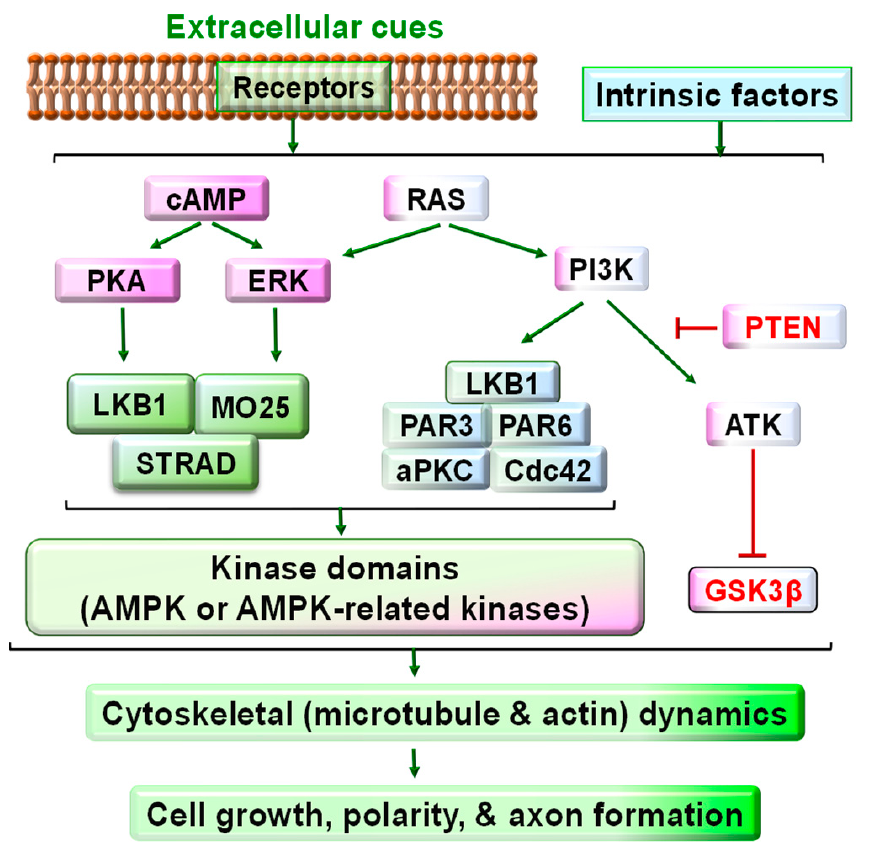
Figure 2. Schematic of the signaling pathways upstream and downstream of LKB1 in developmental neurons. Various extracellular cues and intracellular intrinsic factors activate many signaling path- ways, including cAMP-PKA, cAMP/RAS-Erk, and RAS-PI3 kinase signaling. Downstream of these pathways, LKB1 is critical to convergent signaling for regulating cell growth. LKB1 usually forms a complex with STRAD and MO25 for LKB1 stability and activation. LKB1 may also form a complex with other proteins, including PAR3/PAR6/aPKC/Cdc42. As an intracellular master kinase, LKB1 is crucial for controlling cell growth, polarity, and axon formation and elongation during development by phosphorylating AMPK and AMPK-related kinases and regulating their activities accordingly. AMPK and AMPK-related kinases are associated with the cytoskeletal (such as microtubule and actin) dynamics and cell growth. Other LKB1-independent intracellular pathways, such as PI3K-Akt-mTOR signaling, may also modulate cell growth by diverse molecular